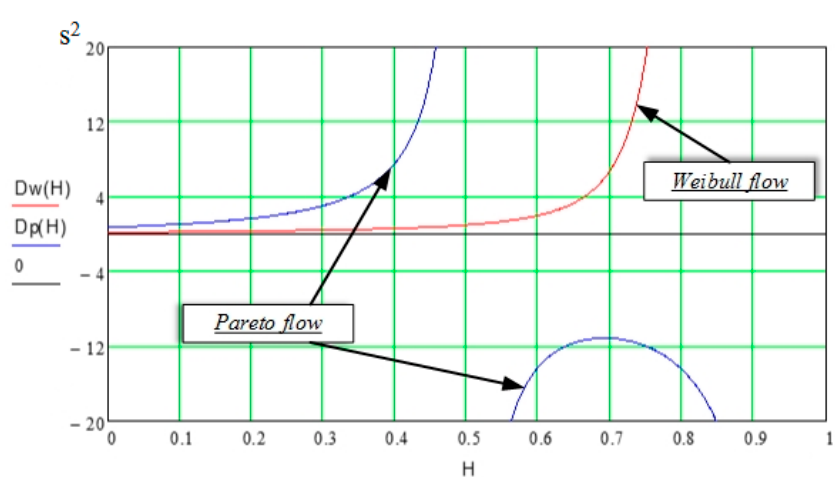
Figure 9. Dependence graph of dispersion of the Pareto and Weibull flows with the parameters of the distribution scale k w = k p = 1.